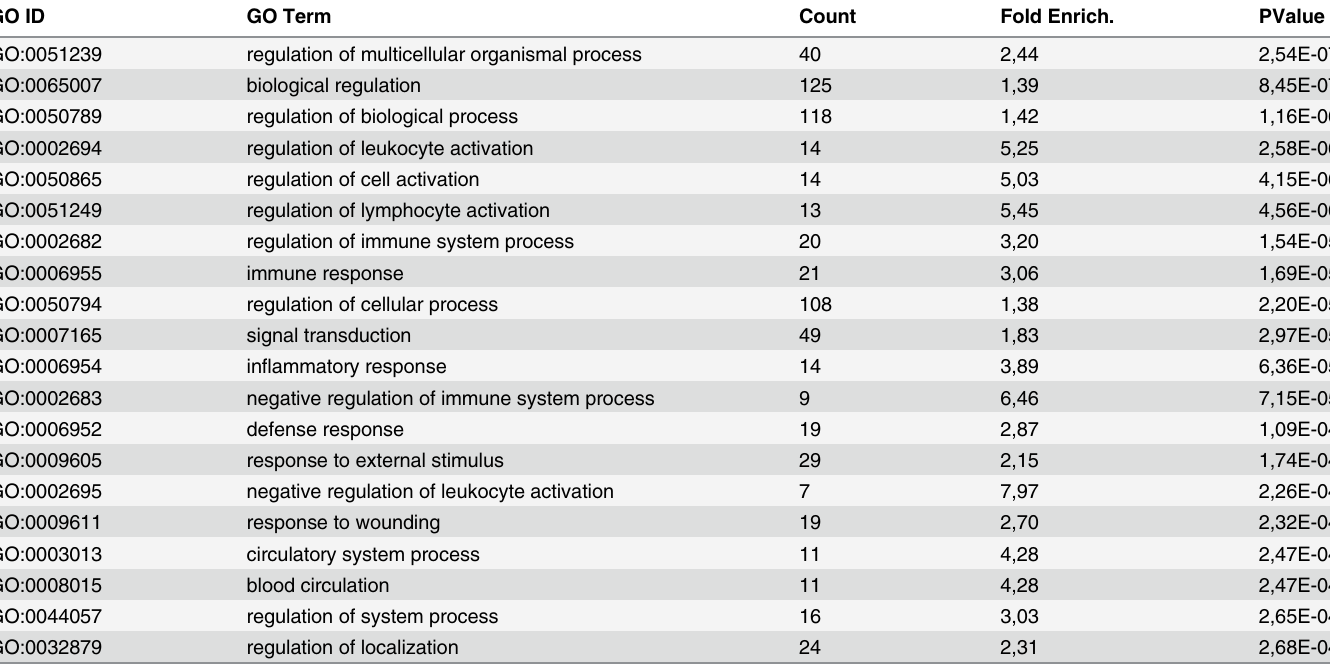
Table 1. List of the first 20 GO terms obtained by DAVID from identified differentially methylated genes altered during early in vitro activation of HSC sorted by p value. GO ID GO Term Count Fold